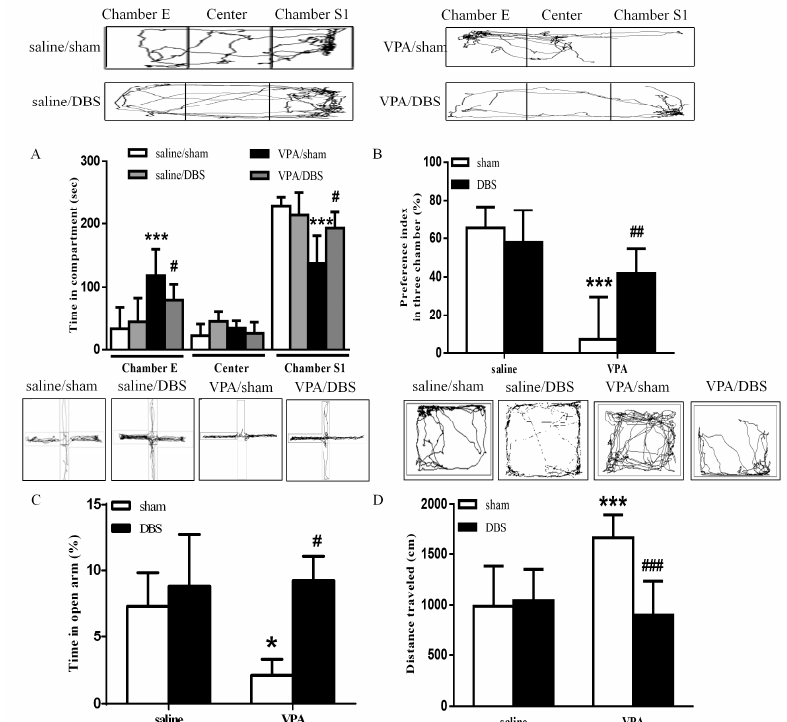
Figure 1. ILPFC DBS improved social interaction, anxiety and hyperlocomotion in the VPA-exposed offspring. ( A ) Time spent by the VPA-exposed offspring in chamber E, the center chamber, and chamber S1 during the three-chamber social interaction test following seven days of DBS treatment; ( B ) preference indices of the saline- and VPA-exposed offspring after DBS treatment; ( C ) bar chart showing the percentage of time spent in the open arms after DBS treatment; ( D ) bar chart revealing the total distance traveled in the open field test. * p < 0.05 vs. saline/sham; *** p < 0.001 vs. saline/sham; # p < 0.05 vs. VPA/sham; ## p < 0.01 vs. VPA/sham; ### p < 0.001 vs. VPA/sham. Sample sizes ( n ): saline/sham n = 7, saline/DBS n = 5, VPA/sham n = 9, VPA/DBS n =